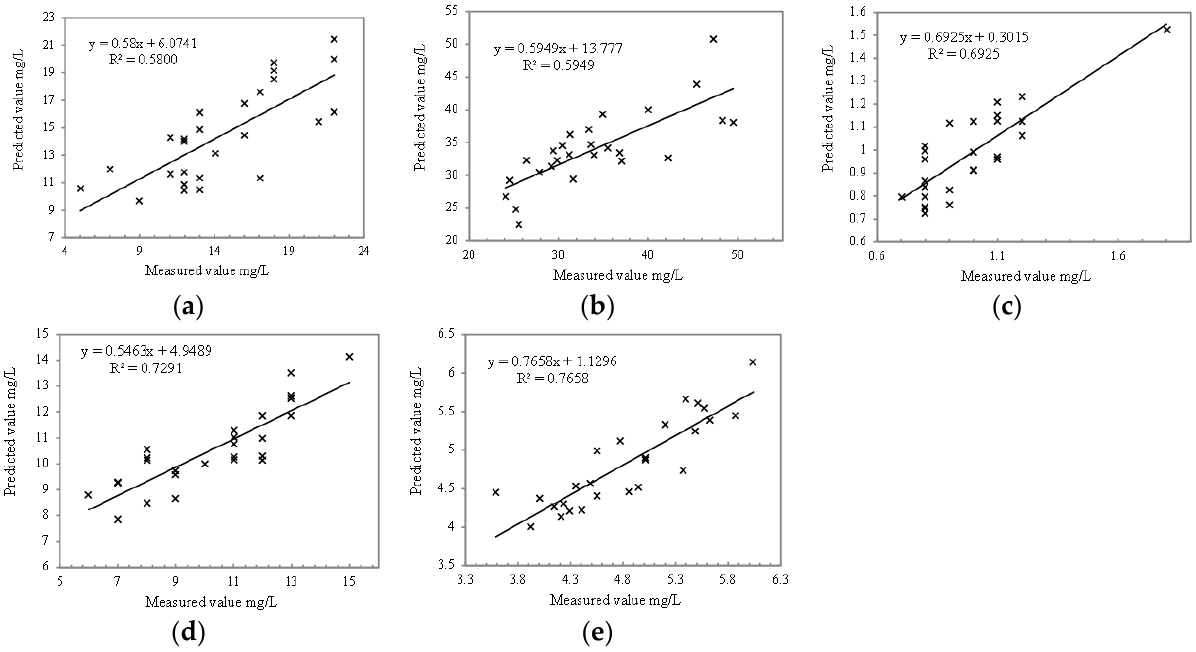
Figure 13. Comparison between the measured and predicted values of each water quality parameter in the modeling dataset. ( a ) Comparison between predicted and measured values of total phosphorus; ( b ) comparison between predicted and measured values of total nitrogen; ( c ) comparison between predicted value and measured value of COD; ( d ) comparison between predicted value and measured value of turbidity; ( e ) comparison between predicted value and measured value of Chlorophyll.